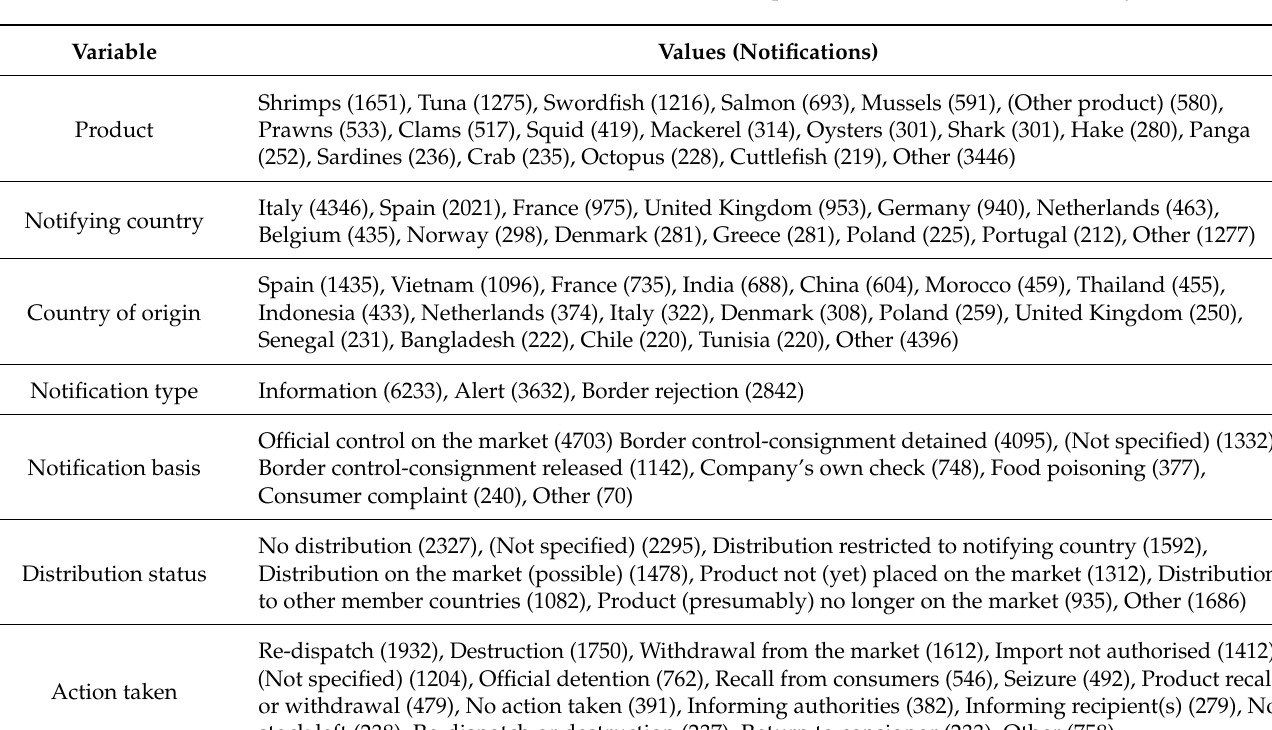
Table 3. Number of notifications on seafood reported in the RASFF in 1996–2020 by